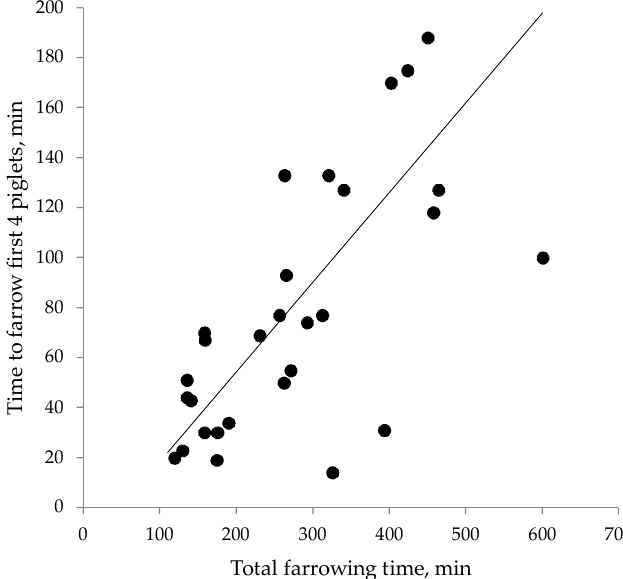
Figure 2. Duration of the entire stage II of parturiton (expulsion of foetuses), in relation to the time taken to farrow the first four piglets. r = 0.74.